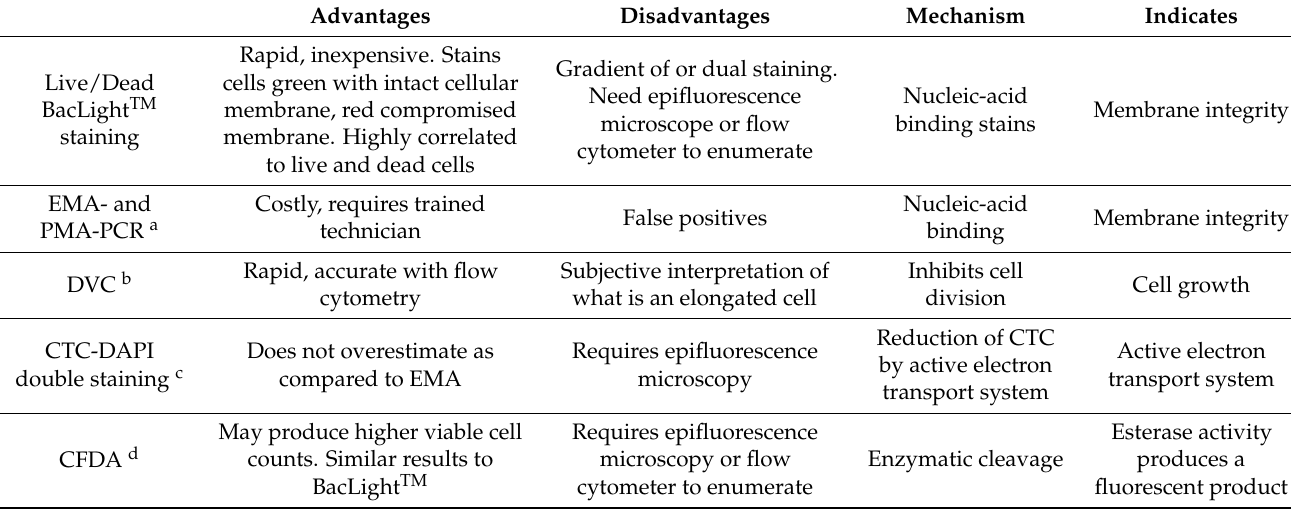
Table 1. Summary of the advantages, disadvantages, and requirements for each of the enumeration